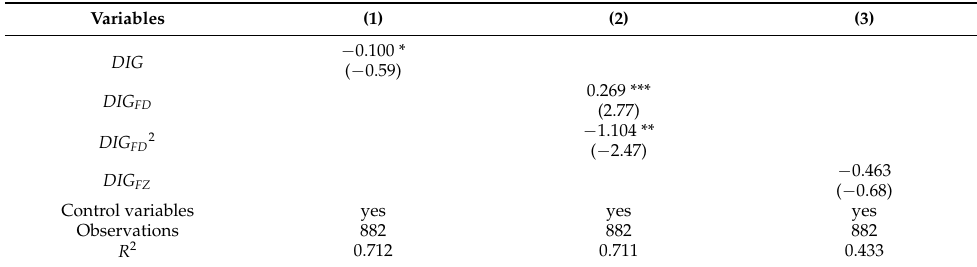
Table 8. Regression results for developing